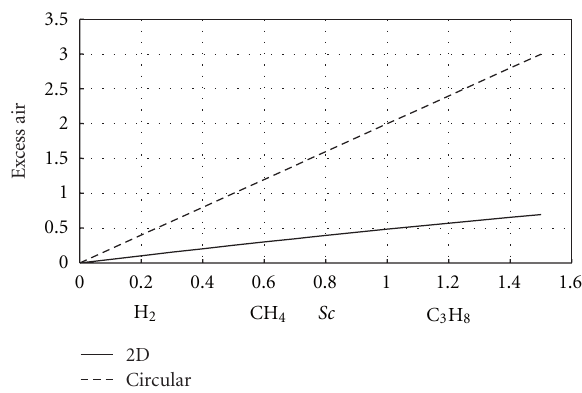
Figure 7: Excess air variation at x = H as a function of Sc for 2D and circular